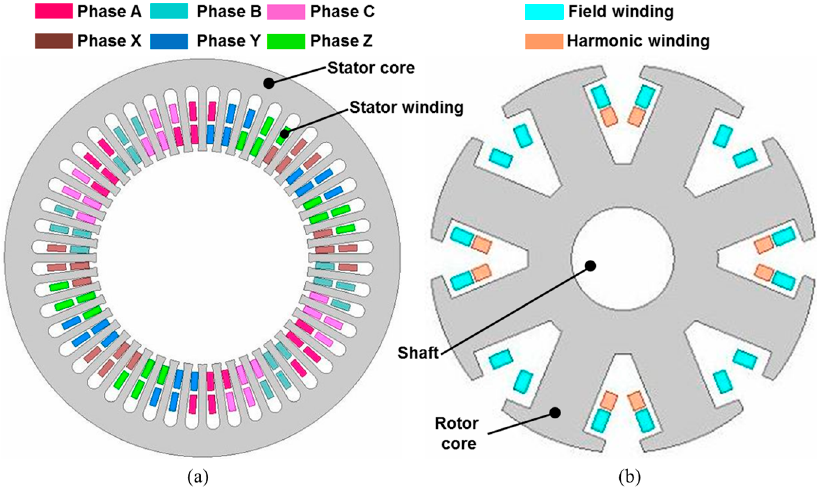
Figure 3. Machine layout (basic model): ( a ) stator with double layer distributed winding; and ( b ) rotor with harmonic and field winding.